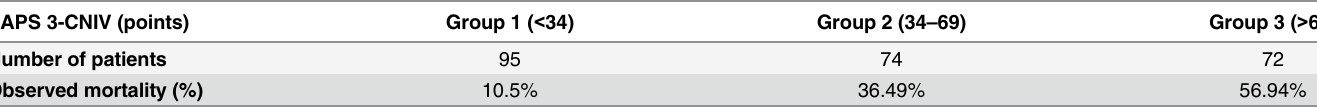
Table 8. Clinical application of SAPS 3-CNIV: Death probability according to customized scores. SAPS 3-CNIV